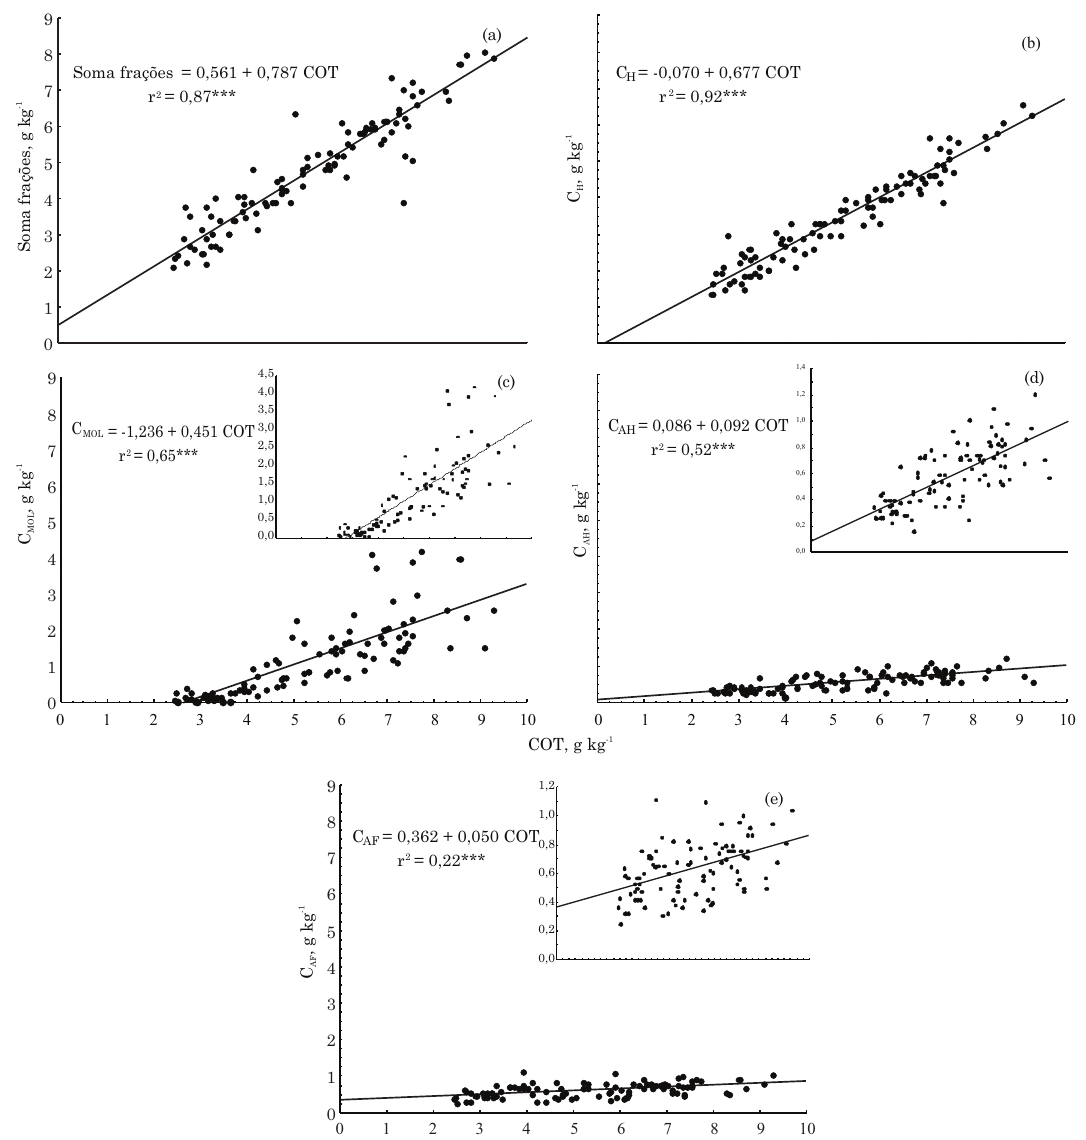
Figura 2. Fator de recuperação do método (Soma frações = C H +C AH +C AF ) (a) e as relações entre carbono orgânico total (COT) com carbono na fração humina (C H ) (b), na matéria orgânica leve (C MOL ) (c) e nas frações ácidos húmicos (C AH ) (d) e ácidos fúlvicos (C AF ) (e) de um Neossolo Quartzarênico, em diferentes áreas de cultivo de soja e milheto, em quatro profundidades de amostragem (n=96). ***: